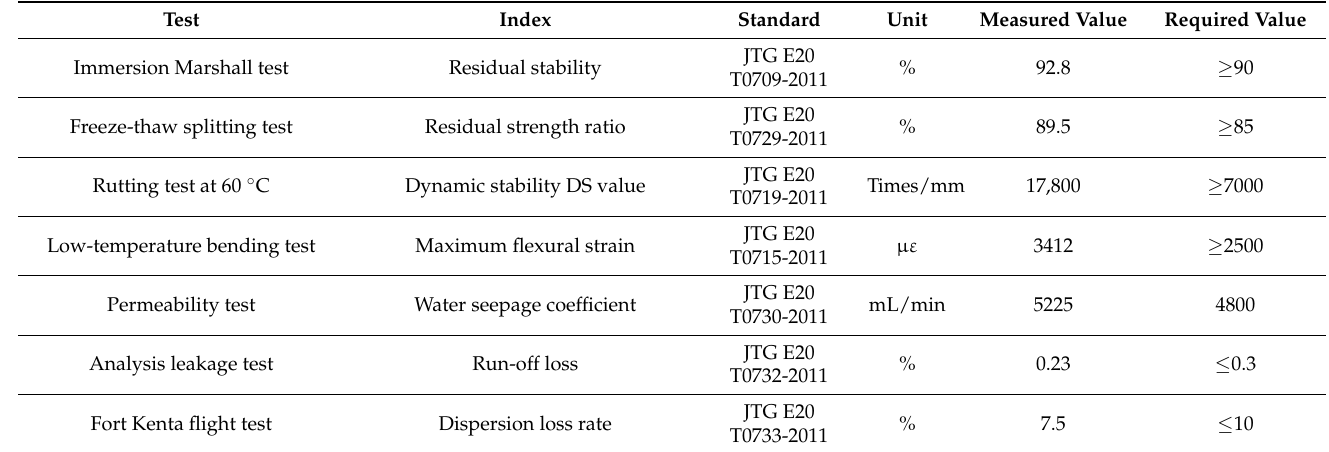
Table 10. Results of OGFC-13 optimum asphalt-aggregate ratio